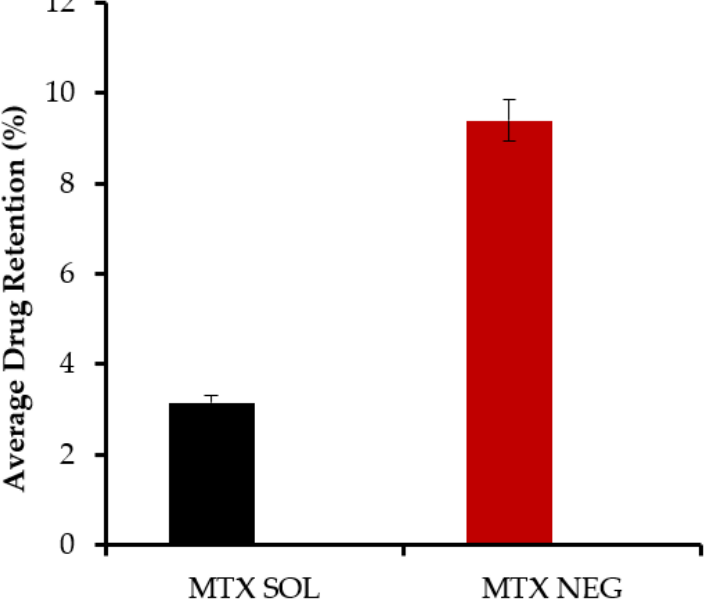
Figure 8. Methotrexate concentrations in the skin from methotrexate solution and methotrexate nanoemulsion gel, respectively, calculated from in vivo studies ( p < 0.001).